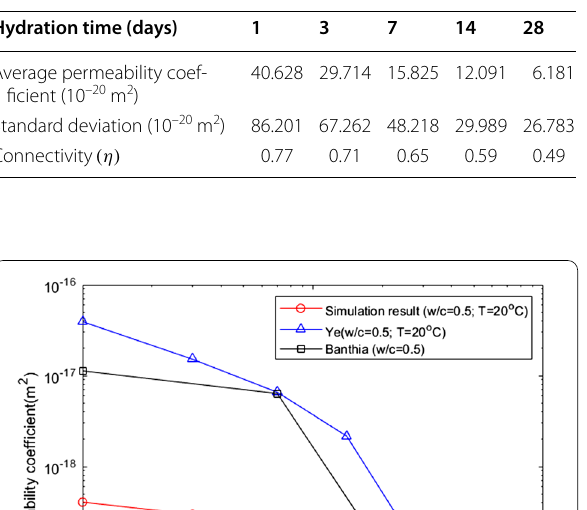
Table 2 Model simulation result for different hydration times.